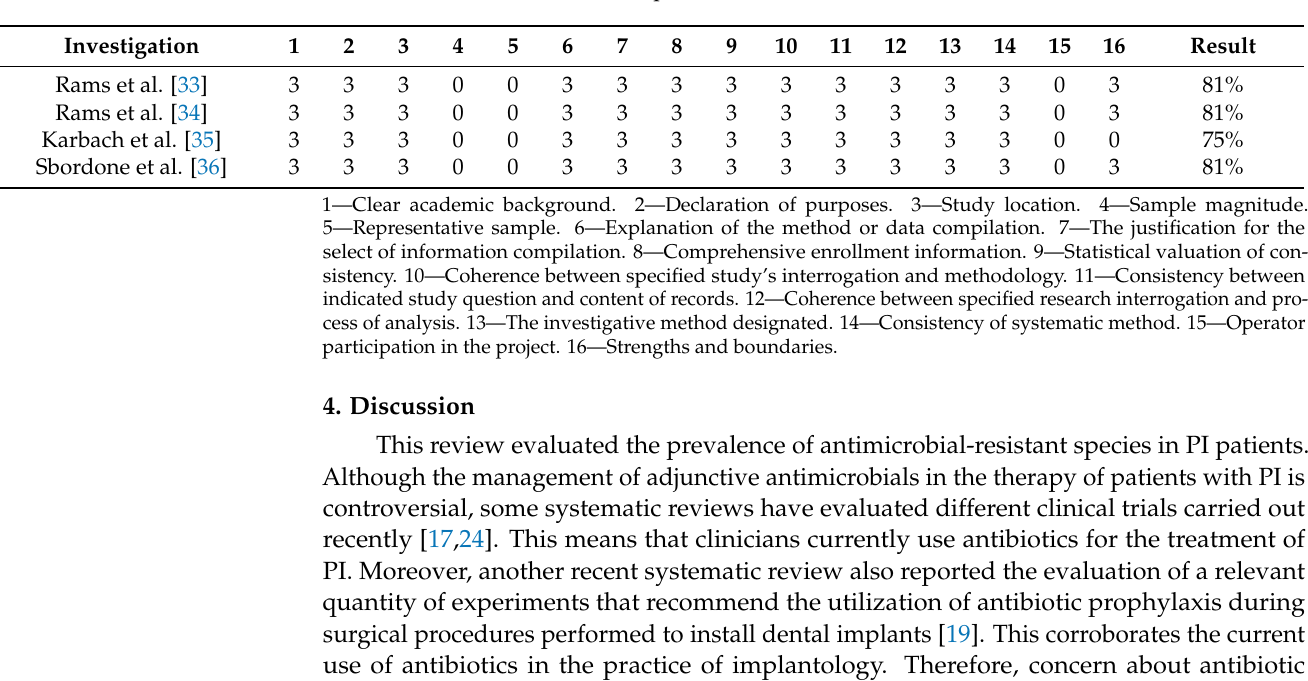
Table 2. Feature of the selected reports